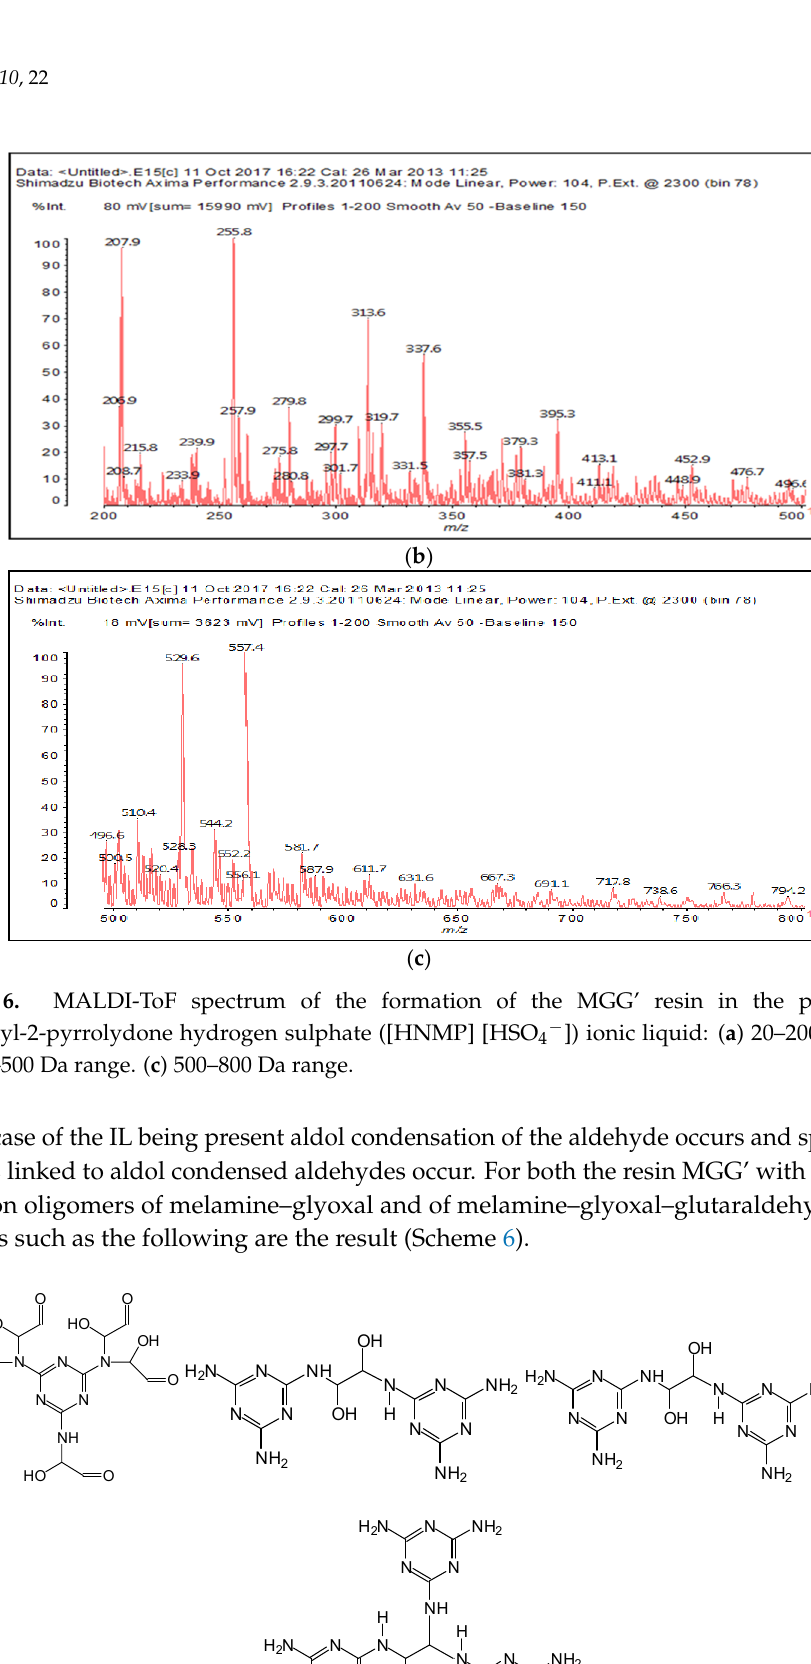
Scheme 6. Oligomers types formed in MG